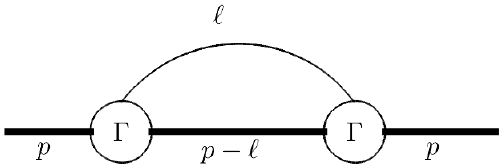
Figure 6 . Infrared divergences in self-energy graphs. As usual the thin line denotes a particle carrying soft